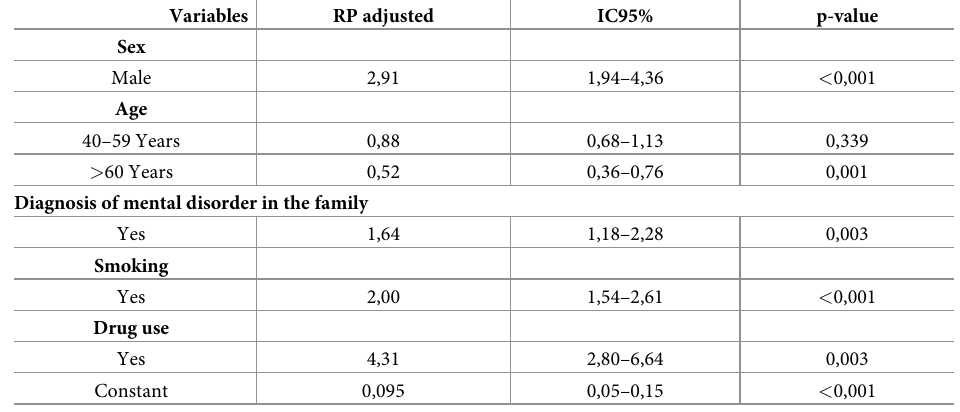
Table 4. Multivariate model between alcohol abuse and its association with socio- demographic and health vari- ables of farmers in the municipality of